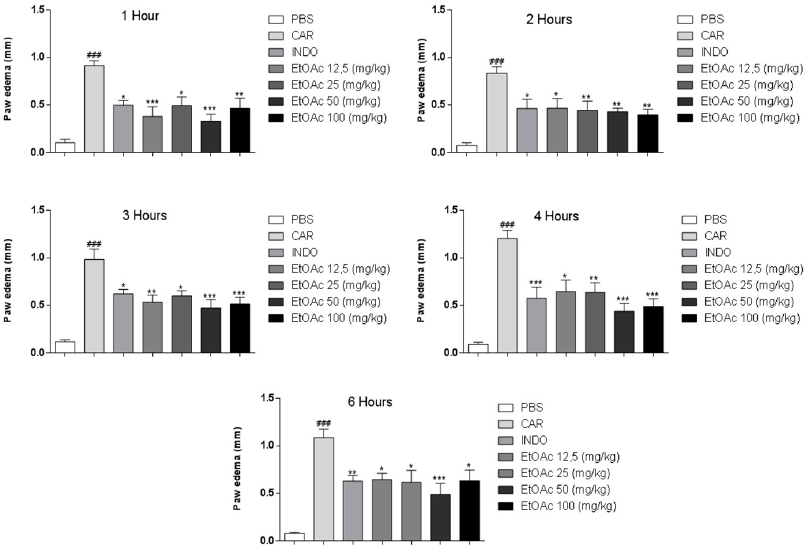
Figure 3. Reduction of paw edema (induced by carrageenan challenge) in the presence of EtOAc of